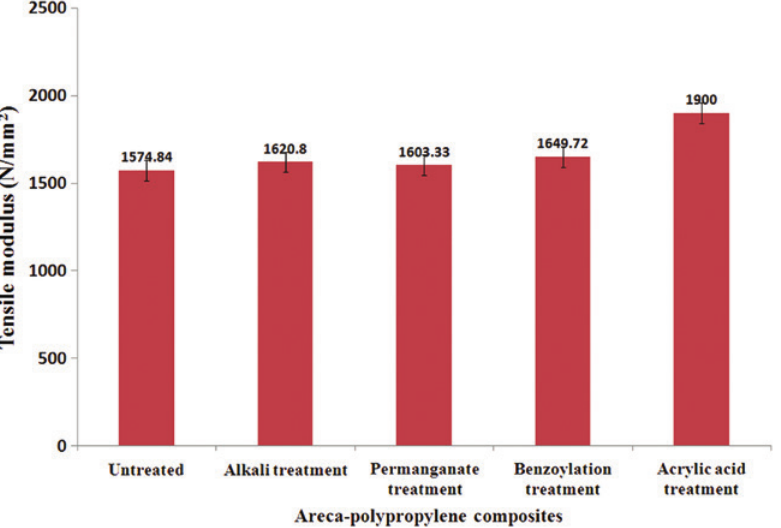
Figure 2: Tensile modulus of areca-polypropylene composites with 60% fiber loading.